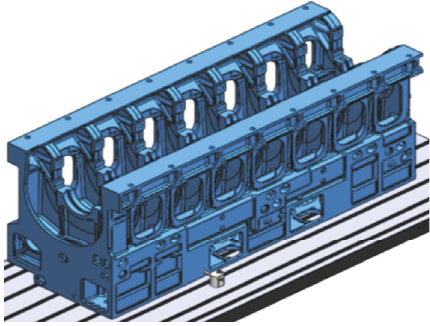
Figure 4: The final model of engine